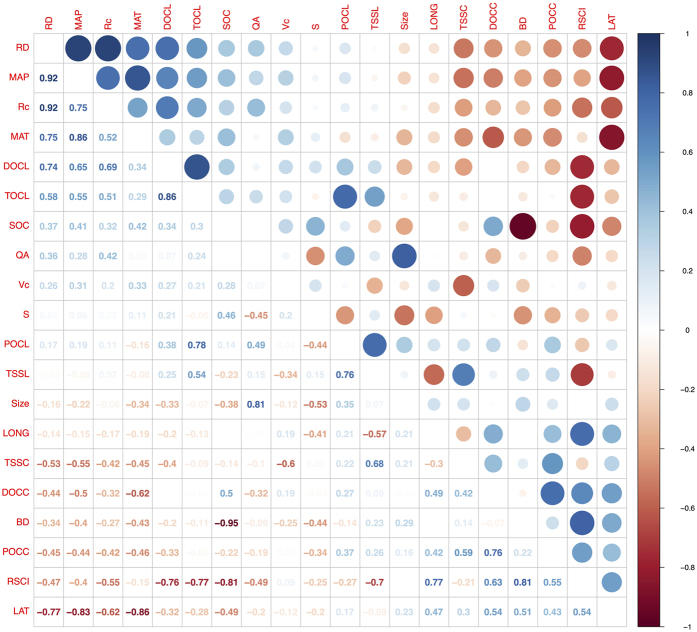
Correlation matrix of variables.Every correlation coefficient which match two variables was calculated with spearman method in R. Abbreviations of the variables as shown in Table 1. Numbers range from −1 to 1 are Spearman’s rank correlation coefficients of variables on horizontal and vertical axes. Colour depth and size of the circles indicate the correlation strength.